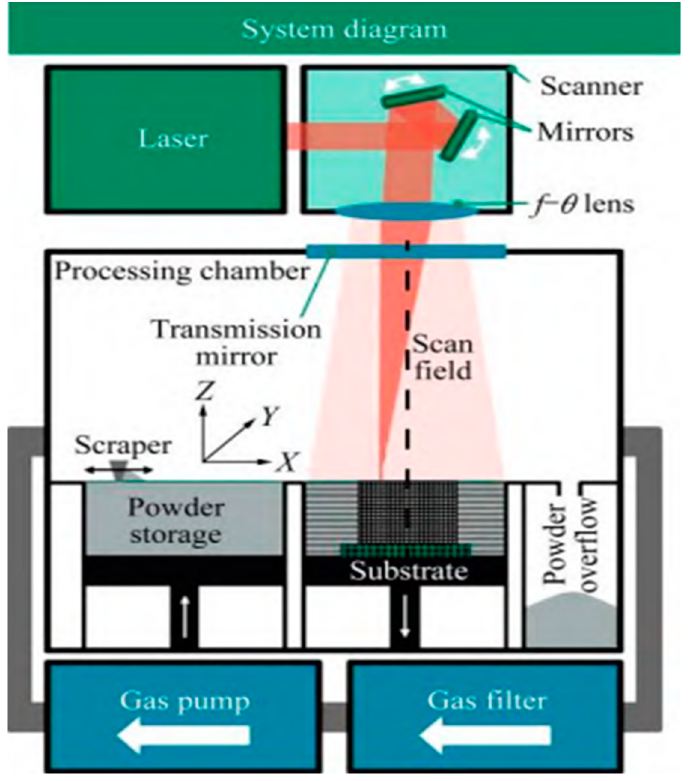
Figure 6. Schematic diagram of selective laser melting machine. Reprinted with permission from [75]. 2019,